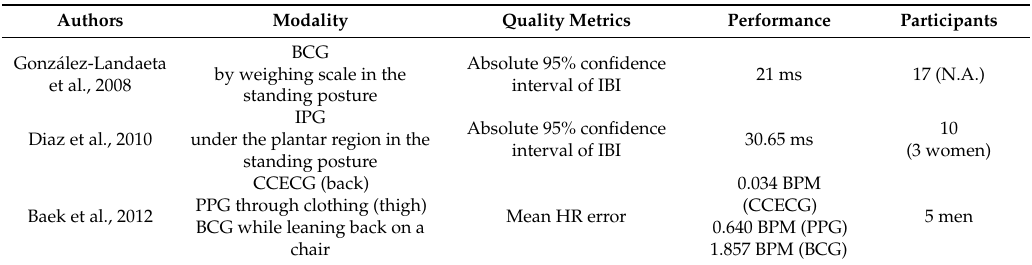
Table 8. Performance of unobtrusive measurements in previous